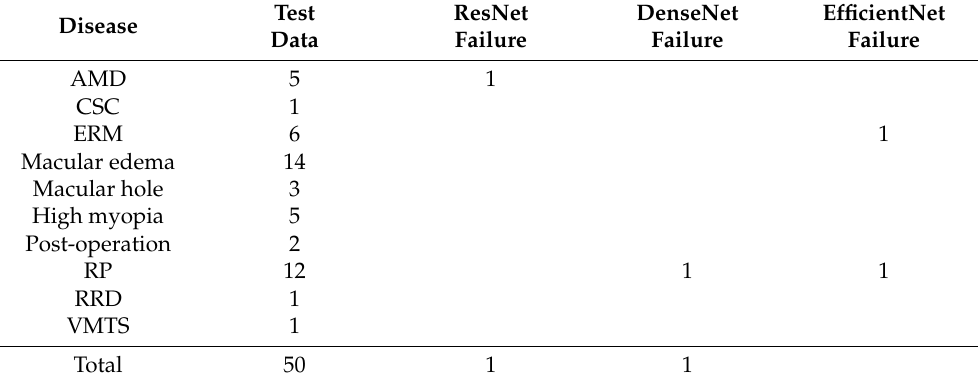
Figure 3. Diagnostic performances of the ResNet ‐ 152 (green), DenseNet ‐ 201 (purple), EfficientNet ‐ B7 (blue), and ensemble models (red). The diagnostic performances of the CNN model with ResNet ‐ 152, DenseNet ‐ 201, and EfficientNet ‐ B7 and the ensemble model were 0.989 (95% CI, 0.968–1.000), 0.997 (95% CI, 0.986–1.000), 0.997 (95% CI, 0.986–1.000), and 0.998 (95% CI, 0.989–1.000), respectively. The diagnostic performance was significantly greater in the ensemble model than in the other CNN models ( p < 0.001). Abbreviations: CNN, convolutional neural network; CI, confidence interval. Figure 4. Representative visual explanations of the feature map of the CNN model in the corrected OCT image. The heat maps in ( A ) macular hole, ( B ) macular edema, and ( C ) epiretinal membrane